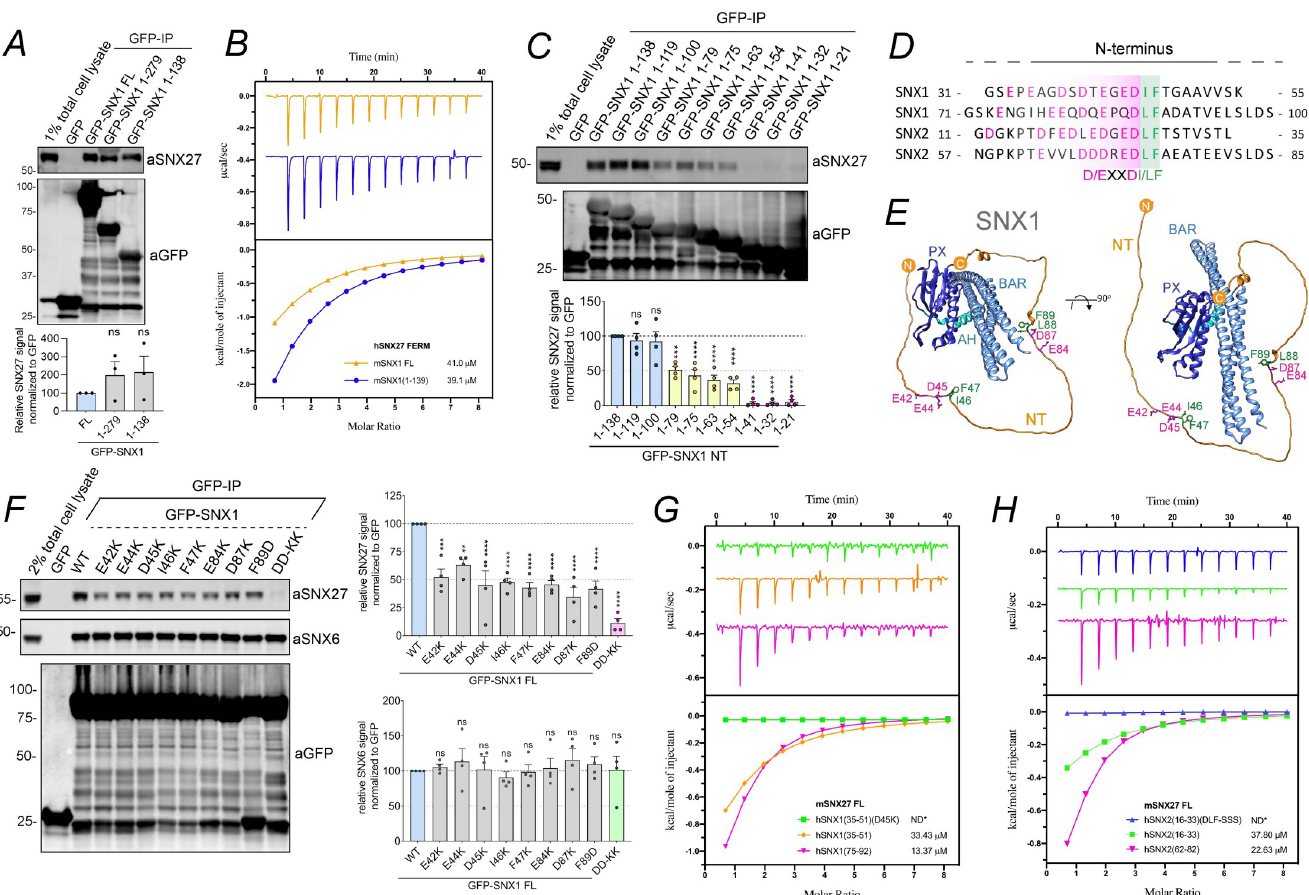
Fig 3. The amino termini of SNX1 and SNX2 directly interact with SNX27 FERM domain through tandem aDLF motifs. (A) Co-immunoprecipitation of GFP- tagged SNX1 FL or truncation mutants corresponding to residues 1 to 279 and 1 to 138 expressed in HEK-293T cells. The cell lysates were subjected to GFP trap– based immunoprecipitation, and the immunoprecipitates were blotted for SNX27 and GFP. The band intensity of SNX27 was measured from n = 3 independent experiments using Odyssey software and was normalized to GFP expression. The relative binding of SNX1 constructs was compared with the SNX1 FL using a 1-way ANOVA and Dunnett test. (B) Binding of mSNX1 FL (orange) and mSNX1 1-139 (blue) with hSNX27 FERM by ITC. (C) Co-immunoprecipitation of GFP-tagged SNX1 amino terminus (1 to 138) and a panel of constructs corresponding to serial truncations of SNX1 amino terminus. The constructs were transiently transfected in HEK-293T cells, the cell lysates were subjected to GFP trap–based immunoprecipitation, and the immunoprecipitates were analyzed by quantitative fluorescence- based western blotting. The band intensity of SNX27 and GFP was measured from n = 4 independent experiments using Odyssey software and was normalized to GFP expression. The relative binding of SNX1 truncation mutants was compared with the SNX1 amino terminus (1–138) using a 1-way ANOVA and Dunnett test. (D) Alignment of the SNX1 regions that are involved in SNX27 binding with the corresponding sequences in the SNX2 amino terminus. The conserved residues between SNX1 and SNX2 account for a consensus motif of acidic residues followed by DI/LF (aDLF motif). (E) Alphafold structural prediction for FL SNX1 [44]. The amino terminus of SNX1 is shown in its full extension and the residues involved in SNX27 binding are colored in red and green. (F) Co-immunoprecipitation of GFP-tagged SNX1 WT and a panel of amino acid swap mutants across the aDLF motifs of SNX1. The constructs were transiently transfected in HEK293T cells, the cell lysates were subjected to GFP trap–based immunoprecipitation, and the immunoprecipitates were analyzed by quantitative fluorescence-based western blotting. The band intensities of SNX27, SNX6, and GFP were measured from n = 4 independent experiments using Odyssey software. The band intensity, normalized to GFP expression, is presented as the average fraction of SNX1 WT. The binding of SNX1 point mutants to SNX27 and SNX6 were compared with the SNX1 WT using a 1-way ANOVA and Dunnett test. (G) Binding of mSNX27 FL and hSNX1 peptides by ITC. SNX1 35-51(D45K) : green; SNX1 35-51 : orange; SNX1 75-92 : lilac; ND � : no binding detected. (H) Binding of mSNX27 FL and hSNX2 peptides by ITC. SNX2 16-33(DLF/SSS) : blue; SNX2 16-33 : green; SNX2 62-82 : lilac; ND � : no binding detected. The ITC graphs represent the integrated and normalized data fit with 1:1 ratio binding. The binding affinity (K d ) is given as mean of at least 2 independent experiments. Thermodynamic parameters for the binding are provided in S1 Table. Molecular masses are given in kilodaltons. Bars, error bars, and symbols represent the mean, SEM, and individual data points, respectively. � P < 0.05, �� P < 0.01, ��� P < 0.001, ���� P < 0.0001. The data underlying the graphs shown in the figure can be found in S1 Data. aDLF, acidic-Asp-Leu-Phe; FL, full-length; ITC, isothermal titration calorimetry; SNX1, sorting nexin-1; SNX2, sorting nexin-2; SNX27, sorting nexin-27; WT,